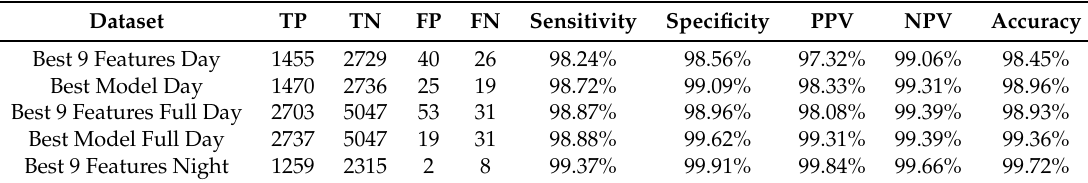
Table 6. RF results for datasets using the nine features models and the best model from the forward selection on night